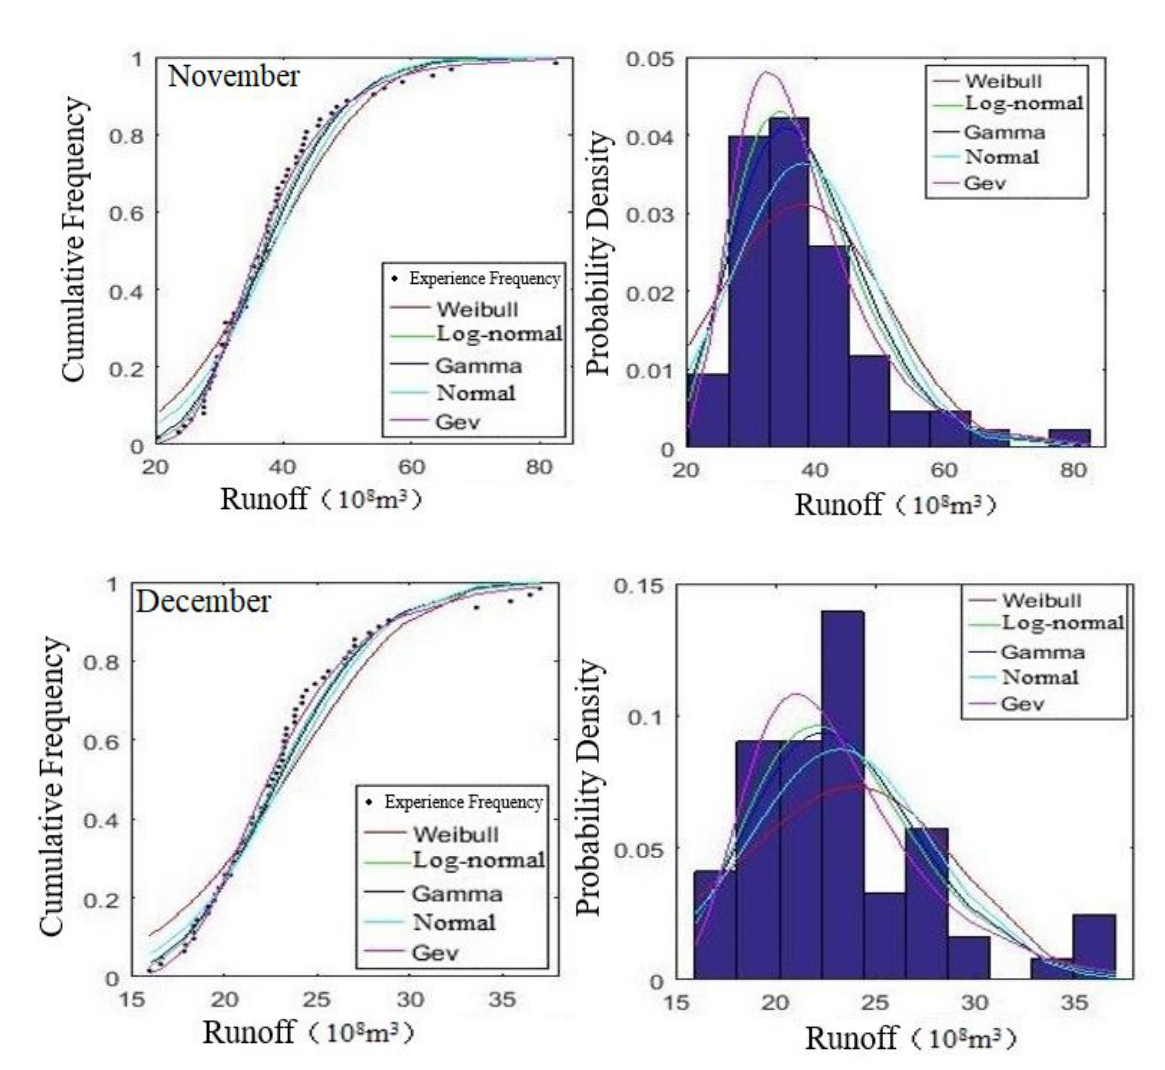
Figure 4. Cumulative frequency and probability density for runoff of the NZD hydropower plant. Table 1. K-S, AIC, and RMSE of incoming runoff in the NZD reservoir.